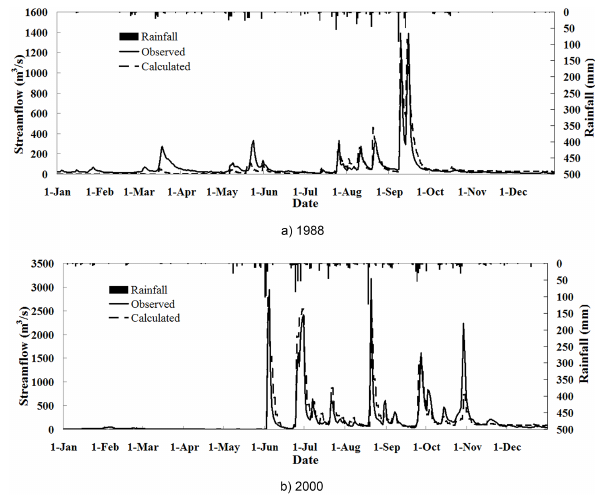
Figure 2. Simulated and Observed hydrographs for the years of 1988 and 2000.